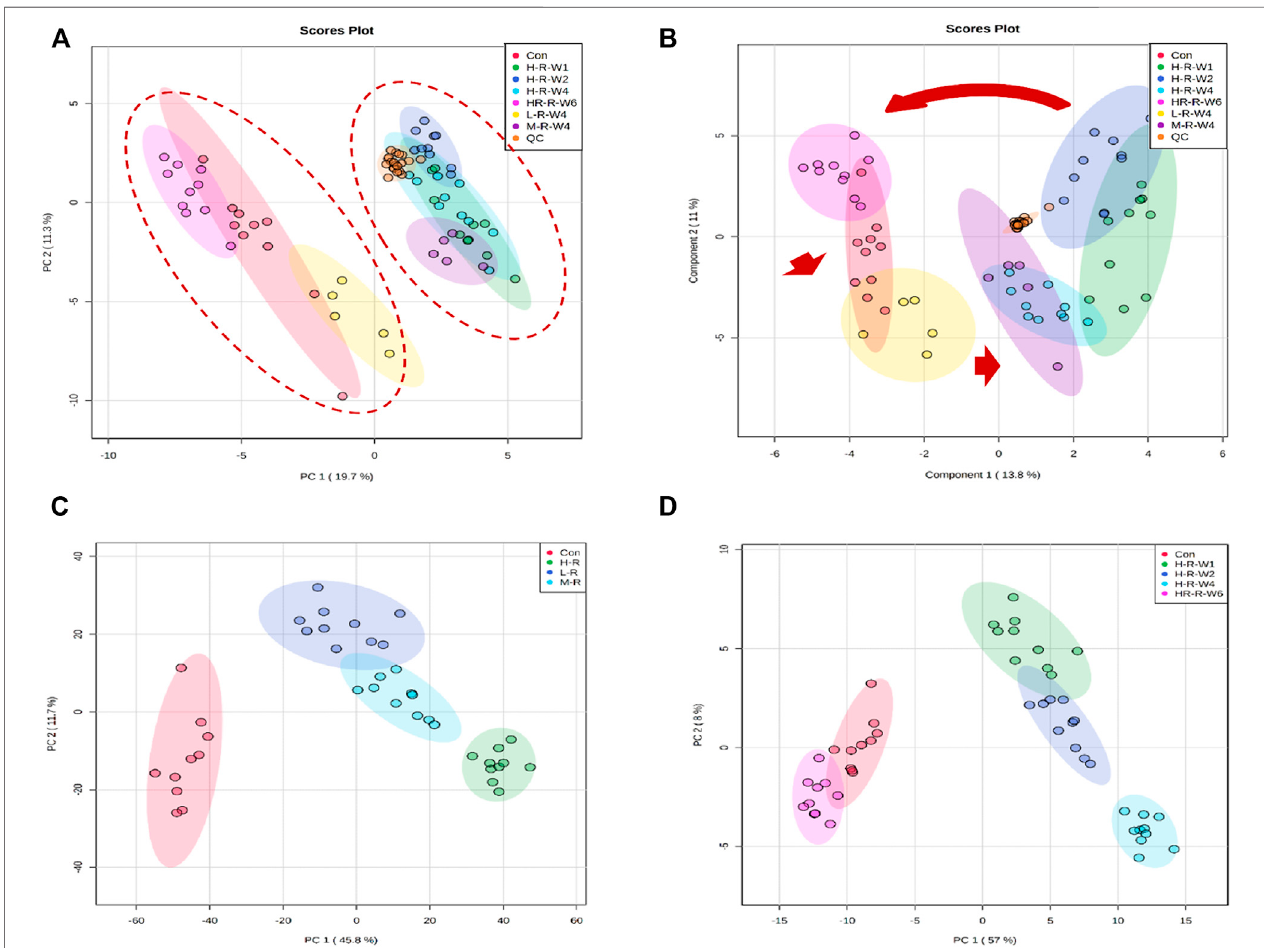
FIGURE 2| Clustering pro fi le ofrat serum samplesafter TR treatment in the positive ion mode. (A) PCA score plot and (B) sPLS-DA plot ofmale rats in the raw TR groups (treated withrawTRfor28 days;L,lowdose; M,medium dose; H,highdose),recoverygroup(HR: 28 days ofhigh-doseTRand followedby14-daysrecovery), control group and QC sample; (C) dose – effect clustering results and (D) time – course clustering results of raw TR groups; (E) control group vs. high-dose raw TR treatment group for 28 days; (F) raw TR group vs. processed TR group after treatment for 28 days; (G) metabolic pathway analysis of high-dose TR in rats after 28 days of